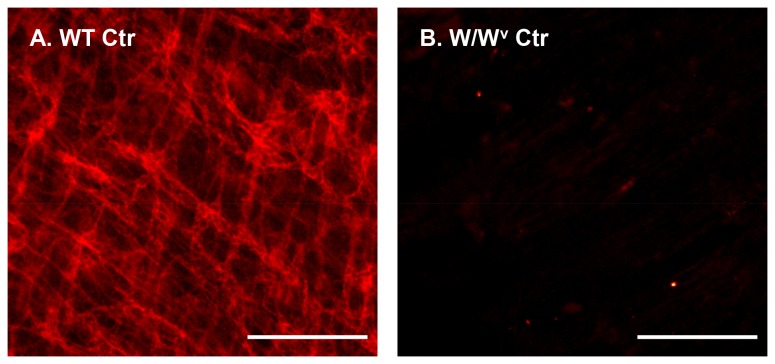
Immunofluorescence staining of ICC in W/Wv mice compared to wild-type mice.Note that W/Wv mice lack c-Kit staining ICC-MY (B) in the colon, compared to that of wild-type mice (A). Images shown are representatives of three independent experiments. Calibration bars = 100 µm.